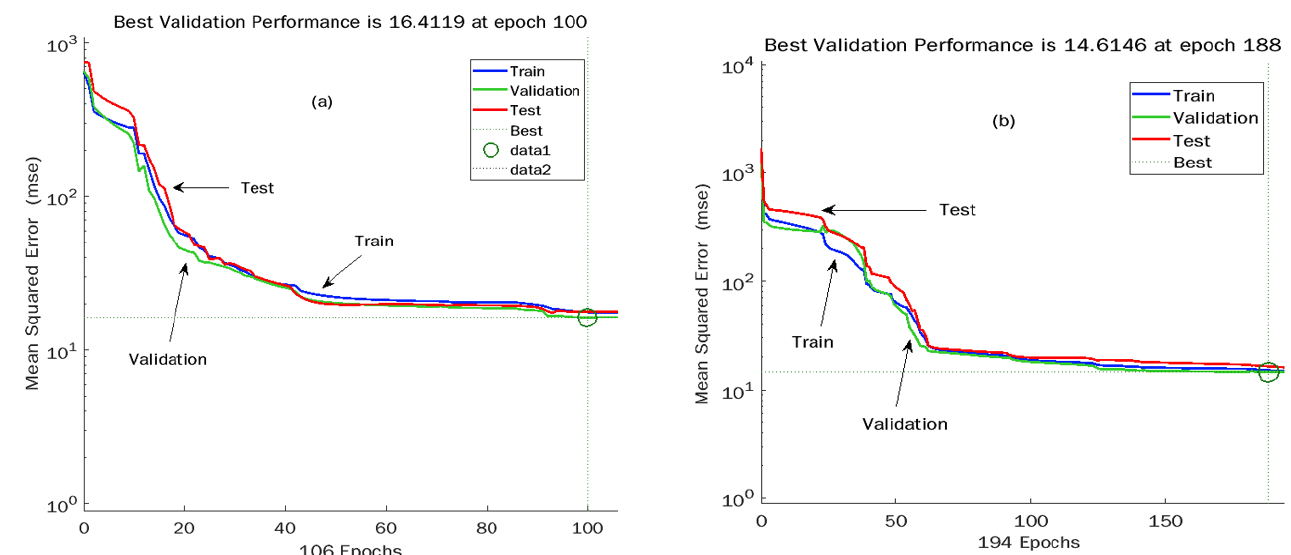
Figure 10. MSE versus Epoch plot for R 3.2 of ( a ) Unaged and ( b ) RTFO binders. Figures 11–14 present the relationship between the measured and predicted values for J nr 3.2 of unaged binder, J nr 3.2 of aged binder, R 3.2 of unaged binder, and R 3.2 of aged binder, respectively. The figures include graphs for training, validation, test, and total data, which indicate excellent R-values for the total data set of 0.997, 0.985, and 0.987 for J nr 3.2 of aged binder, R 3.2 of unaged binder, and R 3.2 of aged binder, respectively. While J nr 3.2 of unaged binder achieved an R-value of 0.937. R-values for J nr 3.2 and R 3.2 of aged binder and unaged binder demonstrated a very good correlation between measured and predicted output values with high accuracy.